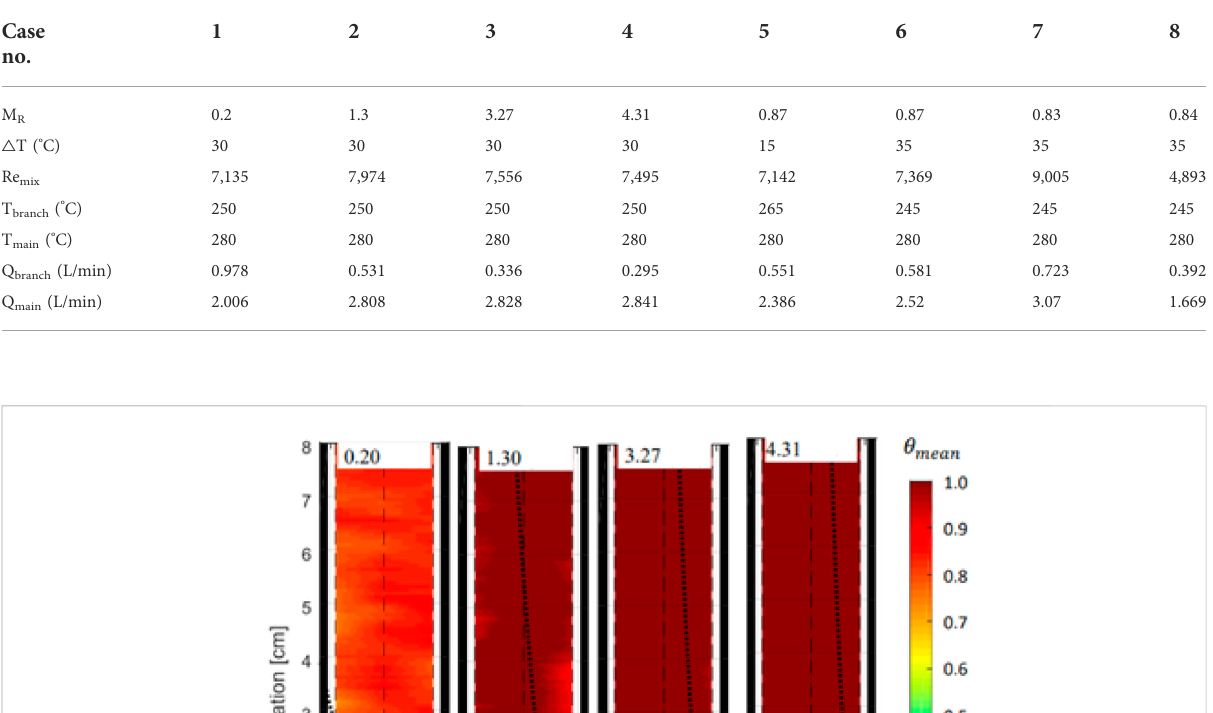
TABLE 2 Parameters of the simulation cases.